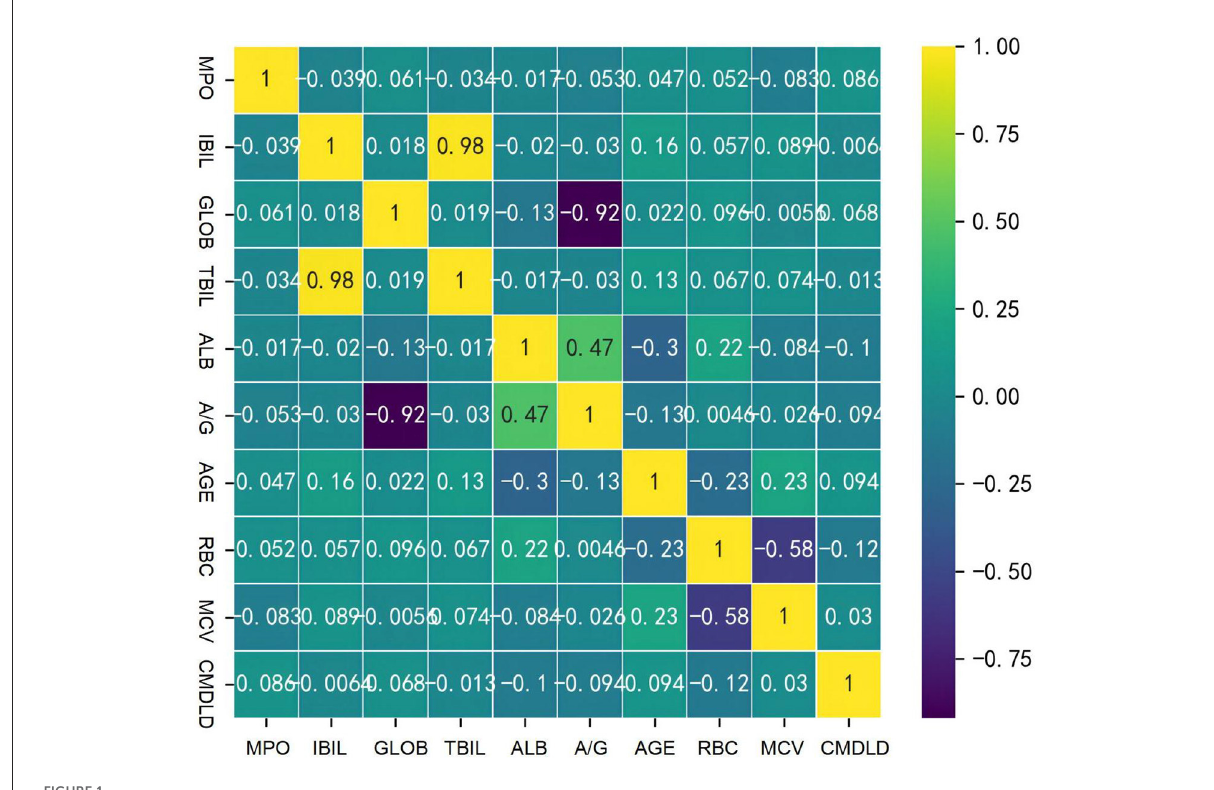
FIGURE1 Heat maps of correlation of clinical features in coal miners.